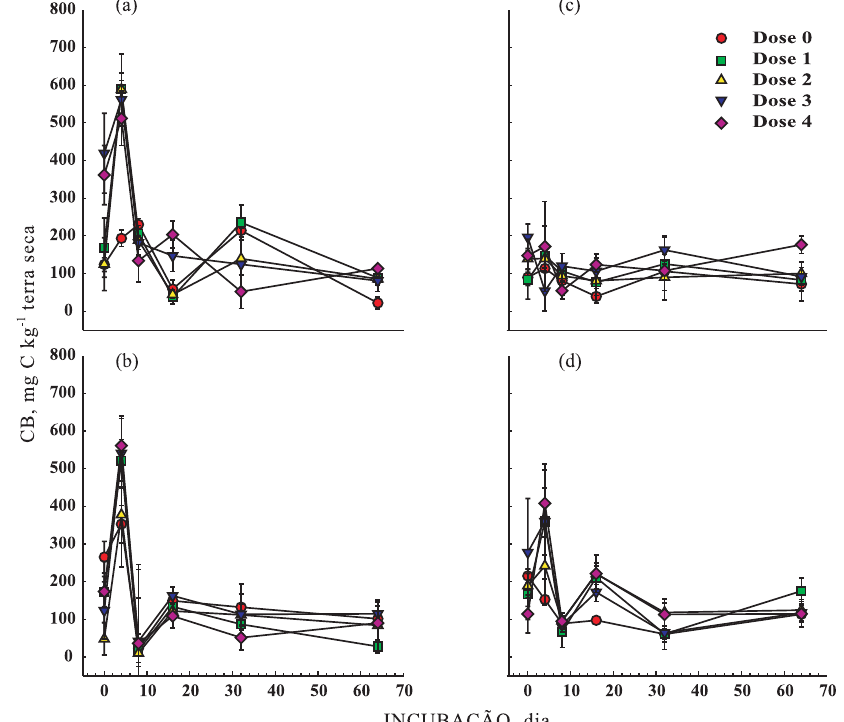
Figura 2. Variação da concentração de carbono na biomassa microbiana (CB) em solo arenoso (a, c) ou argiloso (b, d) tratado com biossólidos da ETE-Barueri (a, b) ou ETE-Franca (c, d). Os dados são médias de 3 repetições ± desvio-padrão da média.